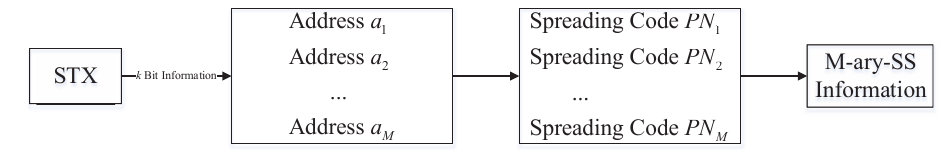
Figure 2. M-ary spread spectrum technology